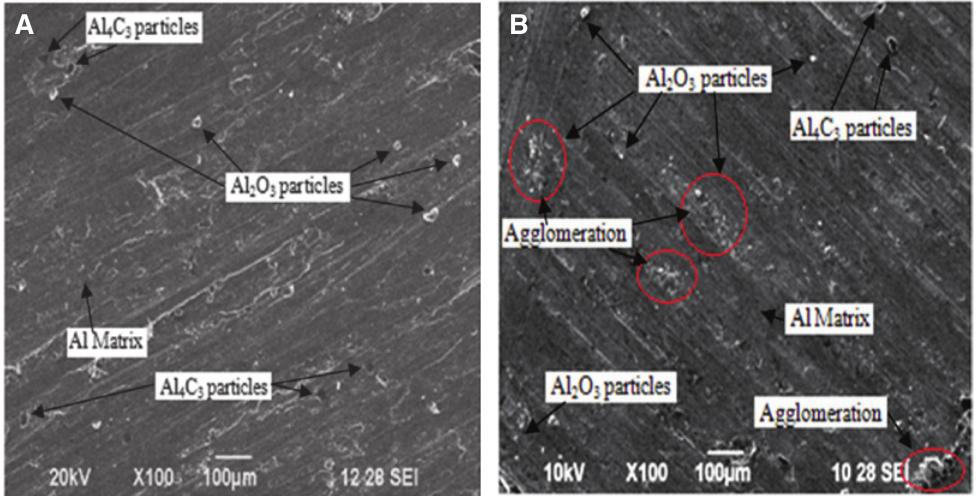
Figure 3: (A) SEM of sample 1 AL6063/10% WSD powder and (B) SEM of sample 2 AL6063/20% WSD